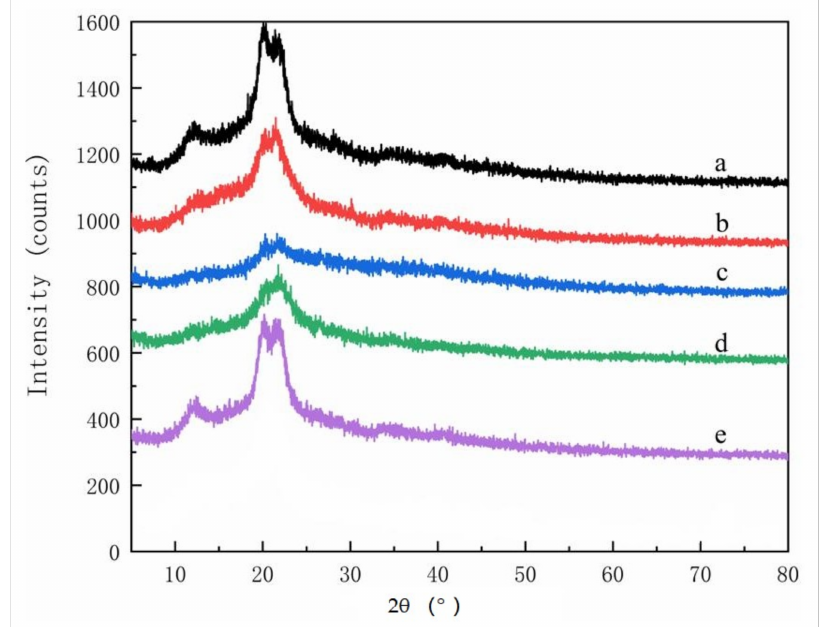
Figure 5. XRD spectra of cellulose derived from ( a ) pine wood, ( b ) bamboo culm, ( c ) pine needles, ( d ) bamboo leaves, or ( e ) hemp hurd.